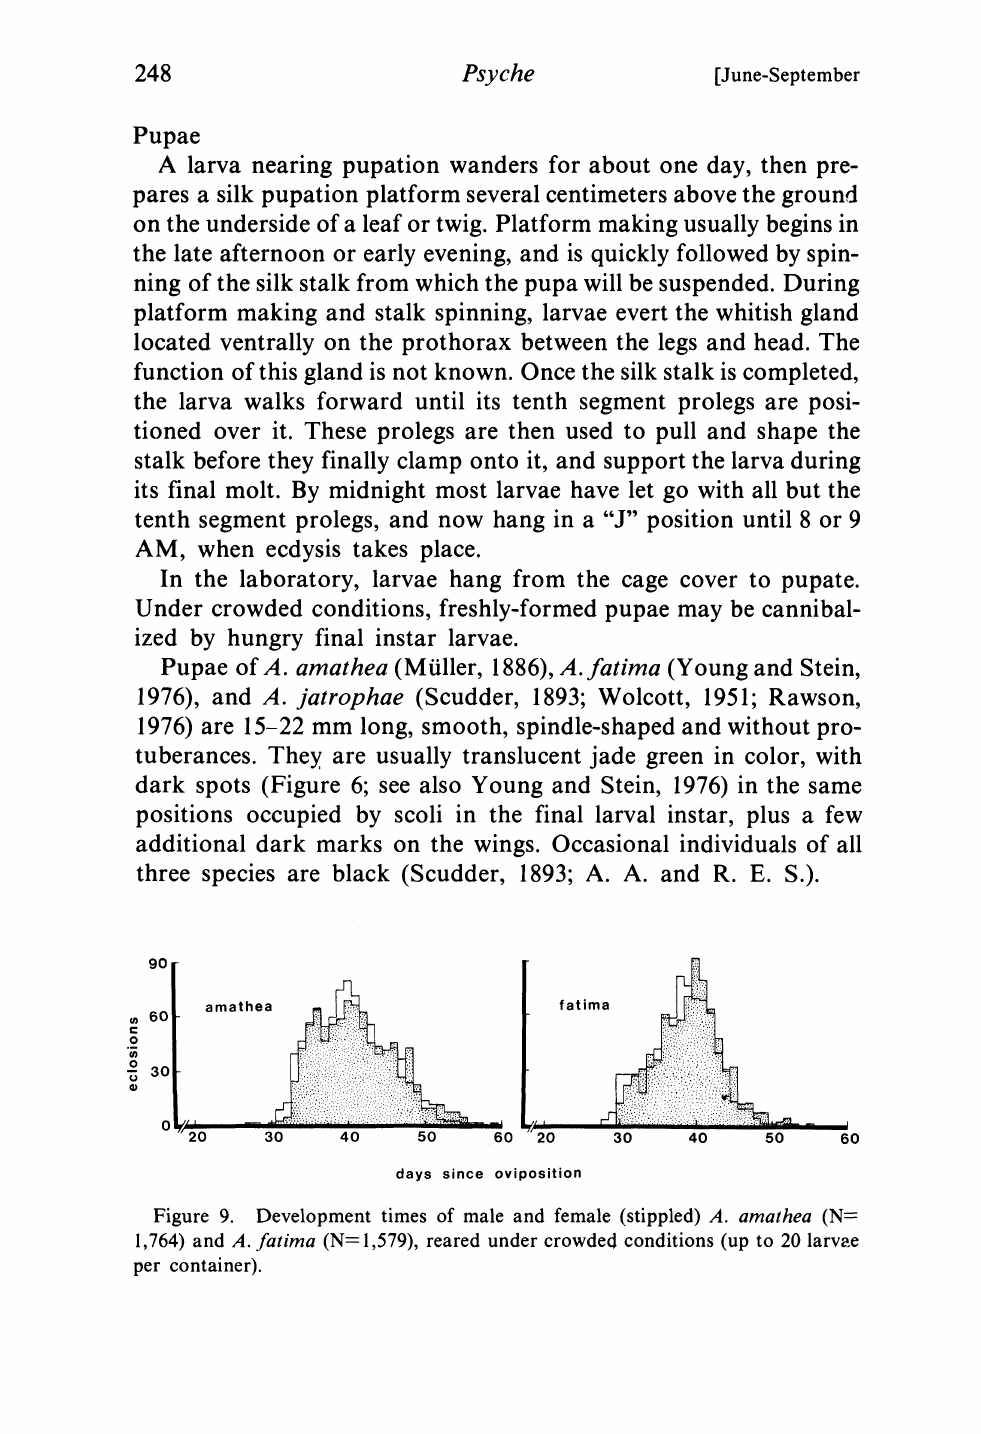
Figure 9. Development times of male and female (stippled) A. amathea (N- 1,764) and A. fatima (N--1,579), reared under crowded conditions (up to 20 larvae per